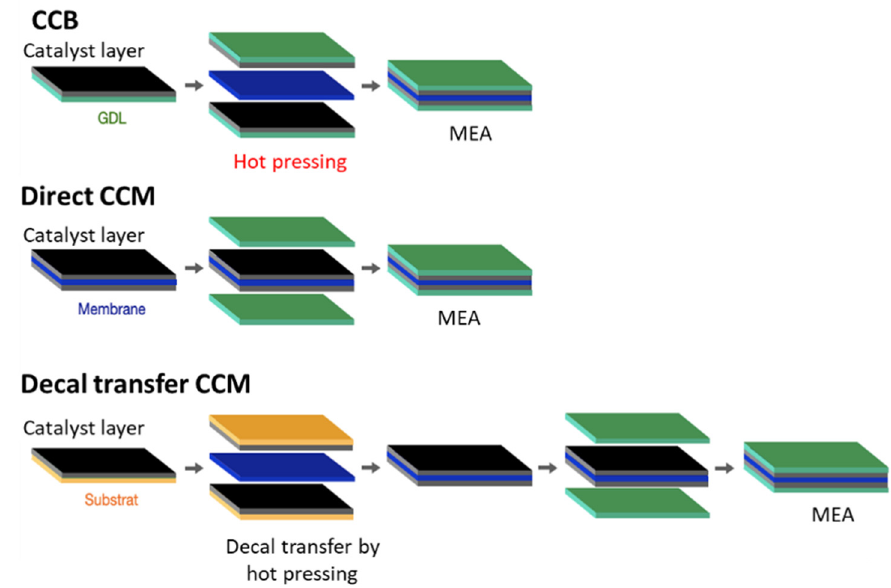
Figure 5. Schematic description of the different processes. Figure 6. Schematic description of the different